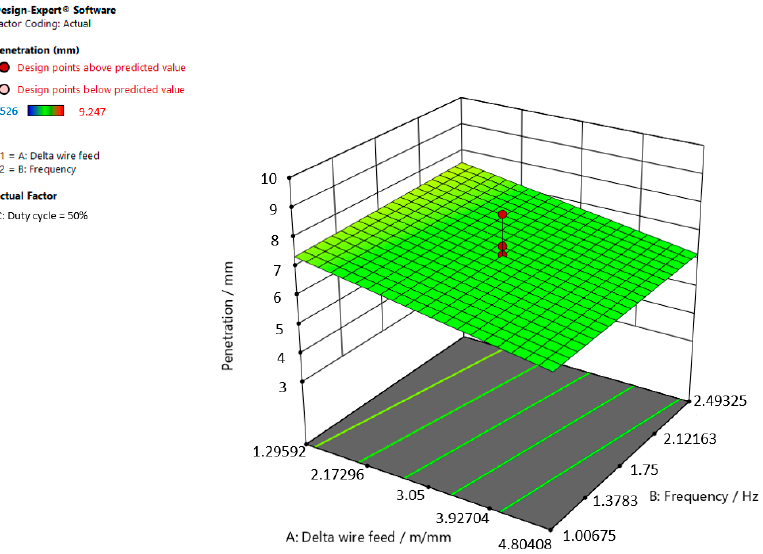
Figure 7. Response surface for the regression model of weld penetration at a duty cycle of 50.00%.